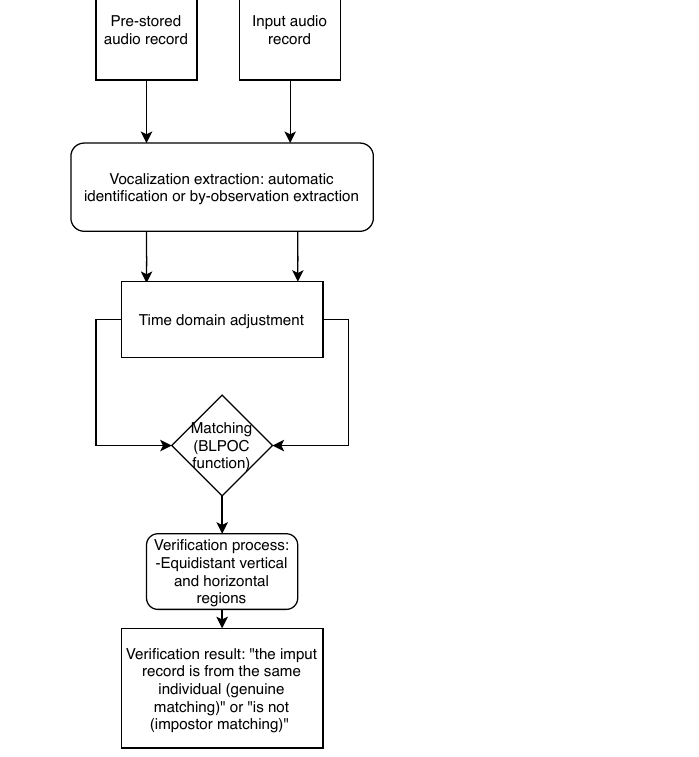
Figure 1. Proposed acoustic individual identification algorithm. Each arrow in the diagram represents a signal